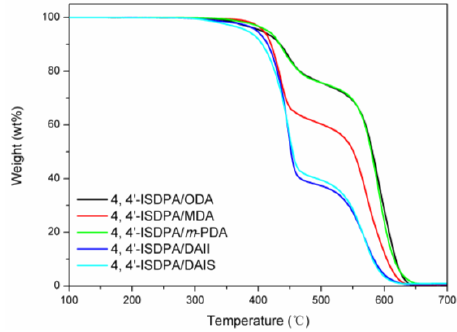
Figure 5. Representative TGA traces of isohexide-derived poly(ether imide)s (PEIs).